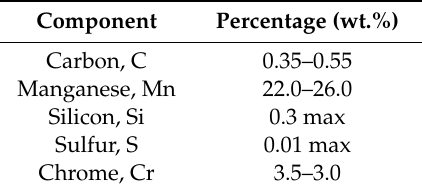
Table 2. Chemical composition of high-manganese steel.